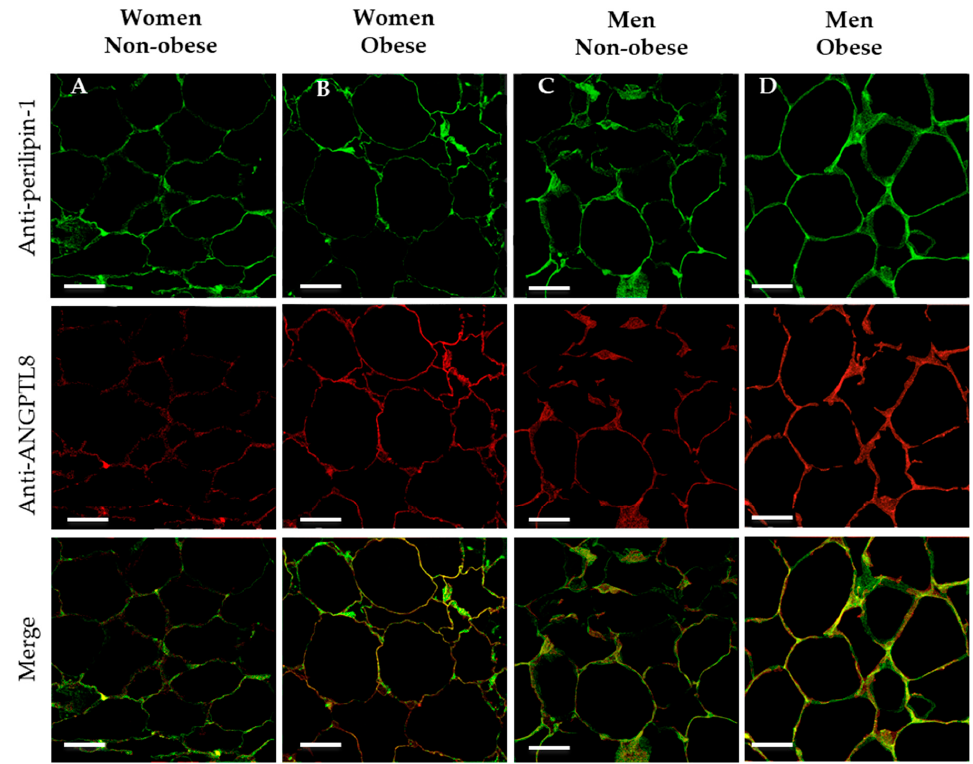
Figure 3. Co-existence of perilipin-1 and ANGPTL8 in human VAT. Representative images showing the double immunofluorescence reaction for positive anti-perilipin-1 (in green), ANGPTL8 (in red) and the merge in adipose cells of patients (in yellow), ( A , non-obese women, n = 4), ( B , obese women, n = 4), ( C , non-obese men, n = 4), ( D , obese men, n = 4). Scale bar: 63 µm. J. Clin. Med. 2020 , 9 , 512